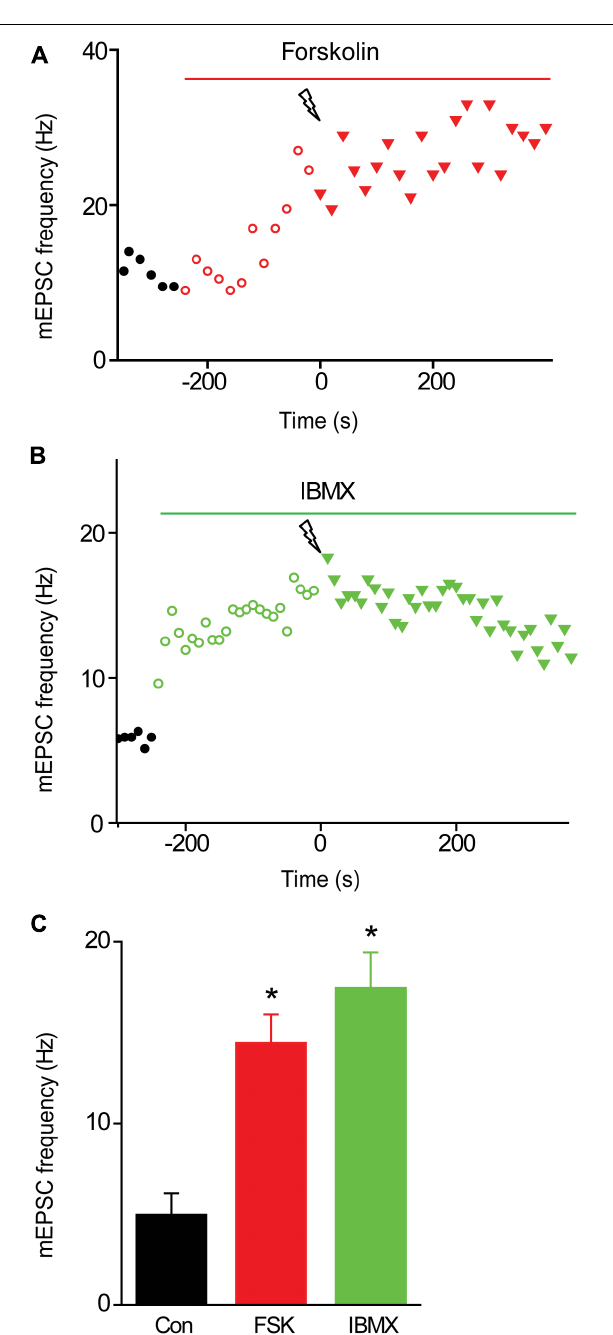
FIGURE 5 | Effects of elevating presynaptic cAMP levels on mEPSC frequency in TWT neurons. (A) Time course of changes in normalized mEPSC frequency (red symbols) produced by application of forskolin (10 µ M) during time indicated by red bar. Electrical stimulation (50 Hz, 2 s) was applied at time = 0. (B) Time course of changes in mEPSC frequency (green symbols) produced by application of IBMX (0.5 mM) during time indicated by green bar. Electrical stimulation (50 Hz, 2 s) was applied at time = 0. (C) Mean values of mEPSC frequency measured in control conditions (black), as well as in the presence of forskolin (FSK; red) and IBMX (green). Values indicate means, error bars indicate ± SEM, and asterisks indicate significant differences compared to values measured in control